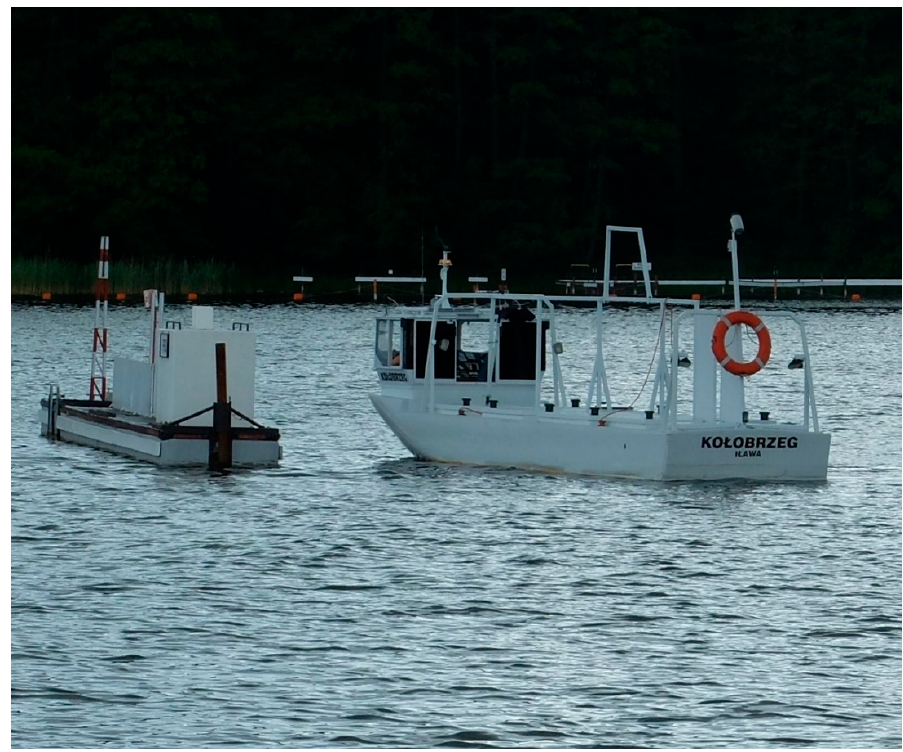
Figure 7. Physical model of the passenger ship Ko ł obrzeg used in the process of testing the AVAL technology.